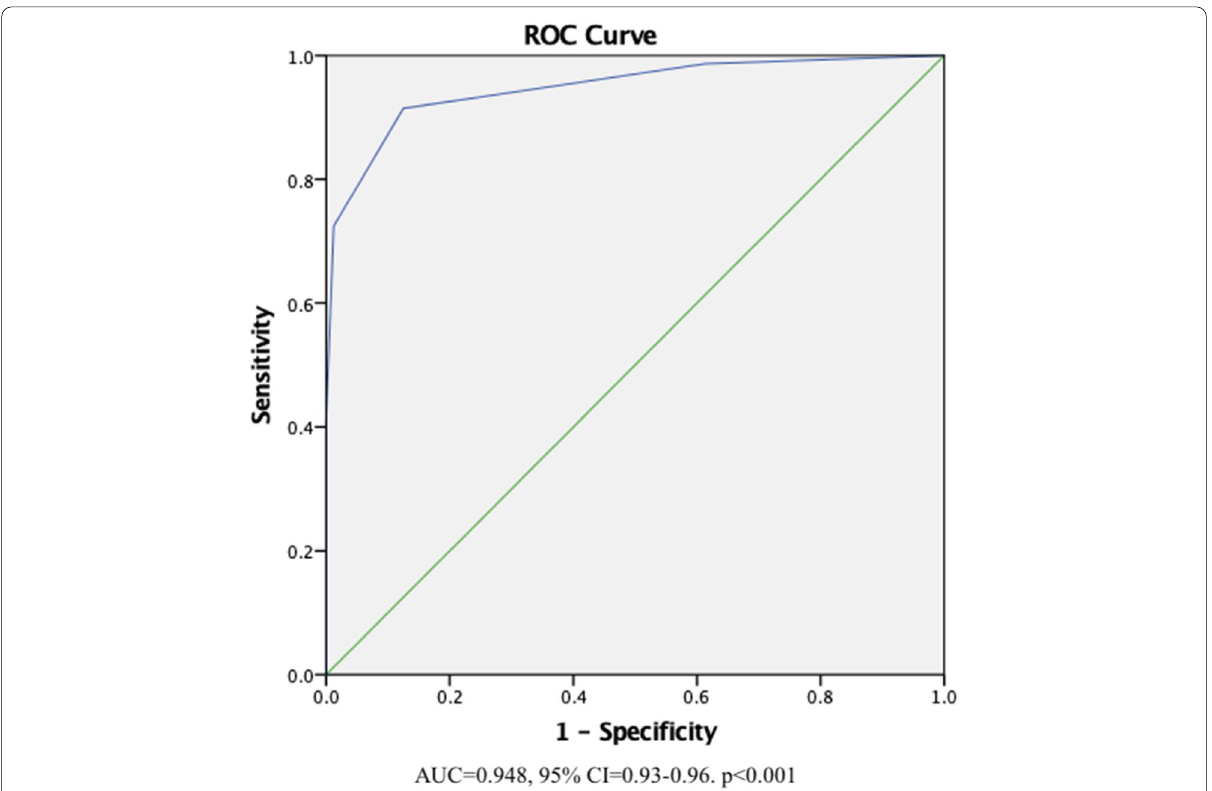
Fig. 1 ROC curve of number of significant variables in differentiating dengue and other febrile illnesses. ROC analysis revealed an AUC of 0.948 with CI 0.93–0.96 and p < = =